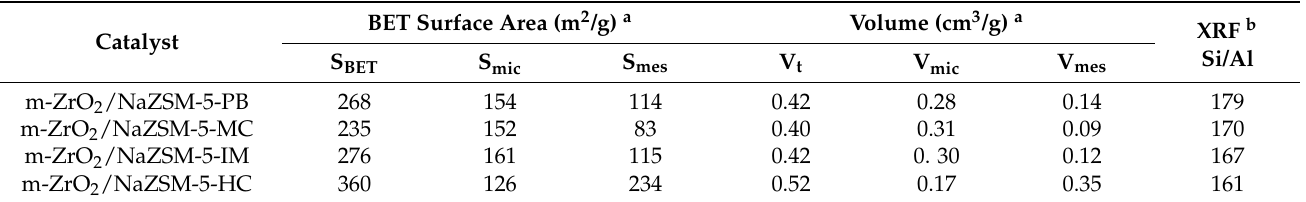
Figure 6. XRD patterns of different composite catalysts. Table 3. Pore structure characteristics and elemental compositions of different composite